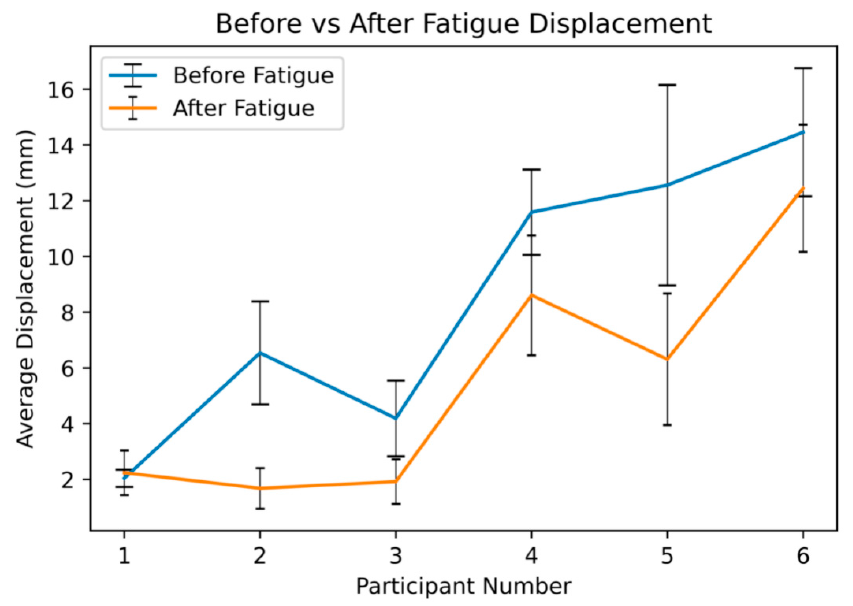
Figure 6. Average feature displacement detected during two muscle stimulation trials (i.e., before and after fatiguing trial).